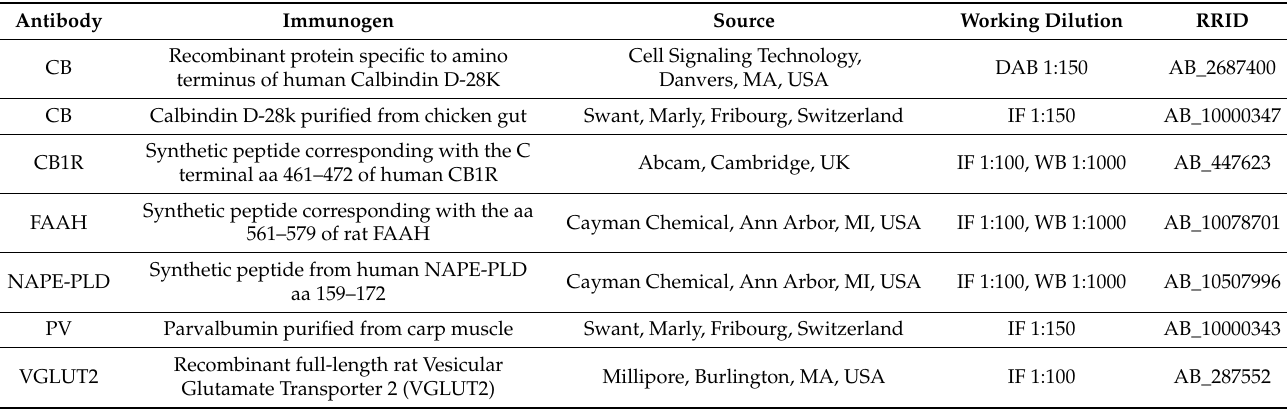
Table 1. Primary antibodies used in this